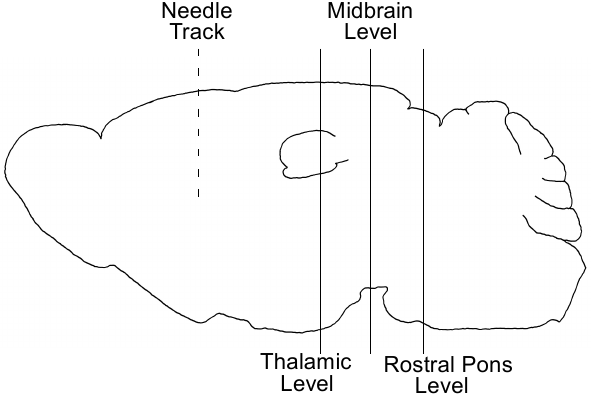
Figure 2. Schematic of the sagittal brain depicting inoculation and coronal section locations. The approximate location of the nt in the striatum (dotted line) and the levels of the three coronal sections (solid lines) analyzed for PrP deposition are shown. The midbrain sections included the substantia nigra and the rostral pons sections included the locus coeruleus.